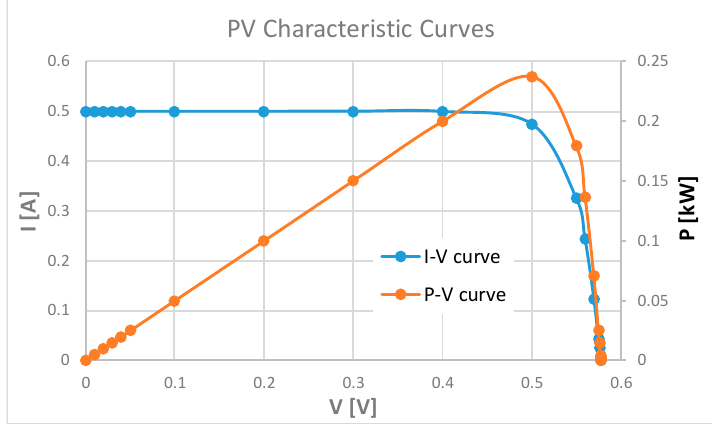
Figure 2. Electrical characteristics current–voltage (I–V) and power–voltage (P–V) of a Si cell. Modified from [44].